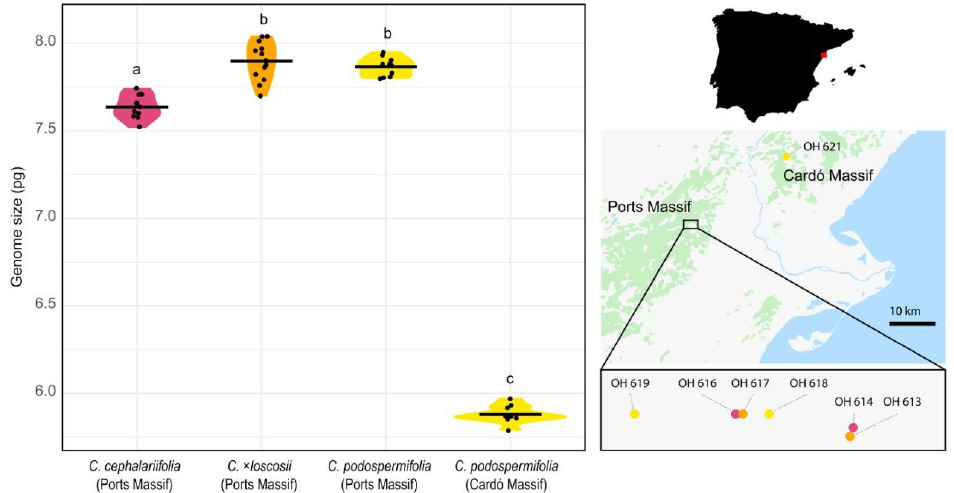
Figure 3. ( Left ) Violin plots showing the distribution of genome size in Centaurea cephalariifolia , C. × loscosii and C. podospermifolia from Ports Massif and in C. podospermifolia from Cardó Massif. Horizontal lines represent the mean and dots indicate the genome size values of each individual. Letters above violins indicate which groups are statistically different from one another (Tukey test, p < 0.001). ( Right ) Location of the sampled populations of C. cephalariifolia (pink), C. × loscosii (orange) and C. podospermifolia (yellow) in Catalonia, NE Spain.